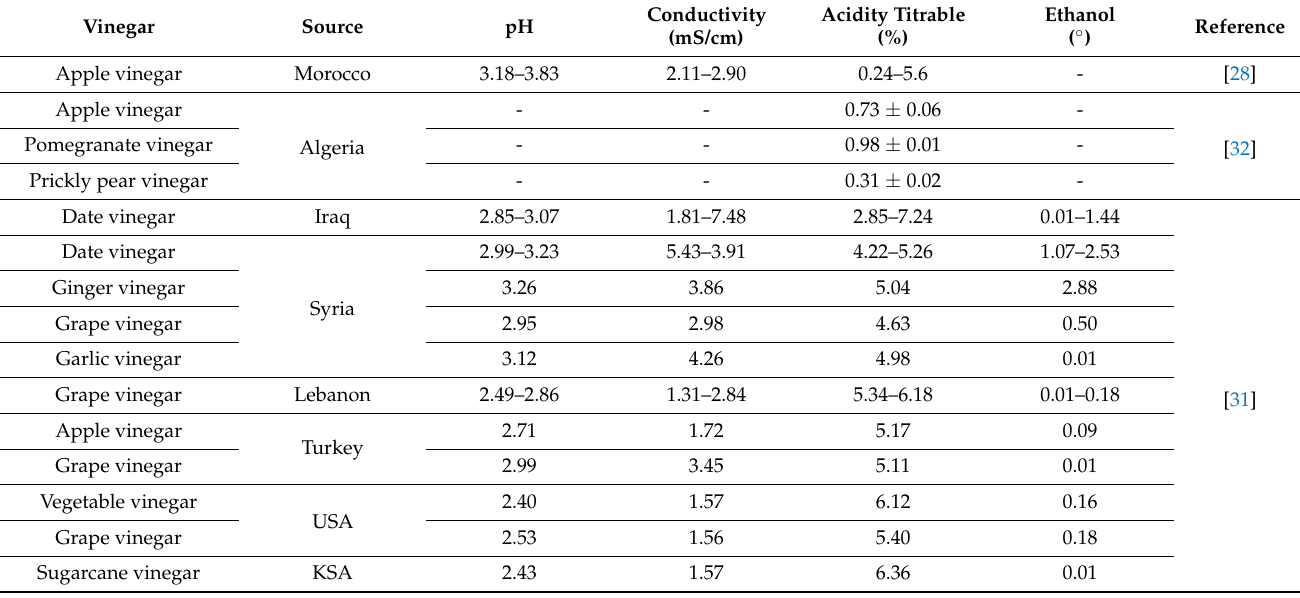
Table 1. Range values of physicochemical characteristics of